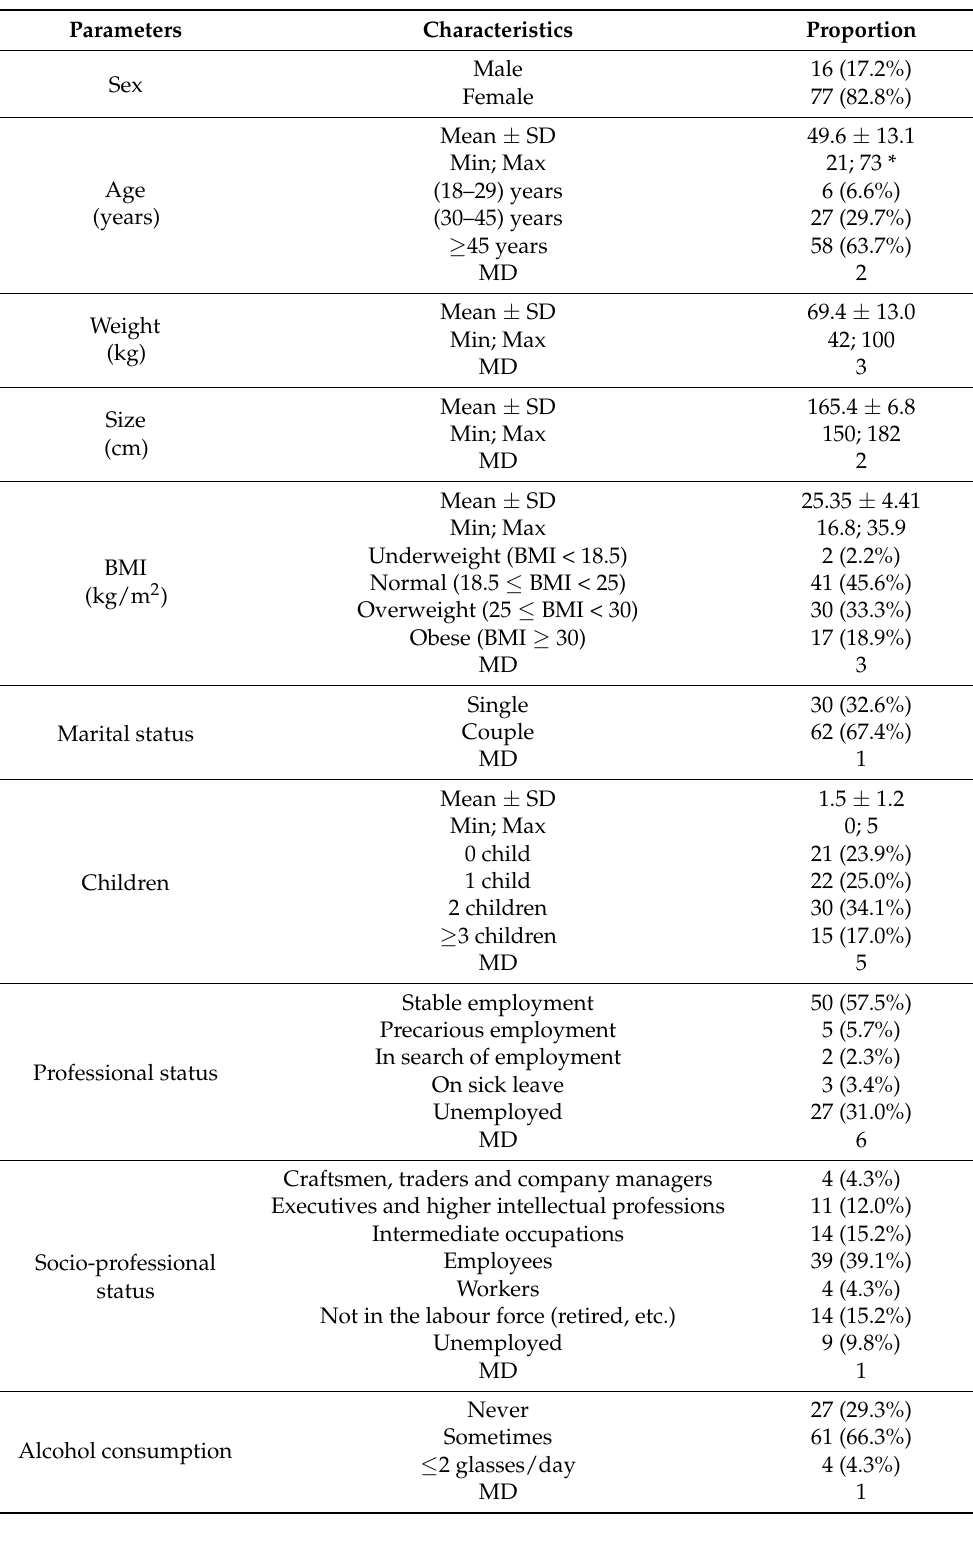
Table 1. Description of the analysed